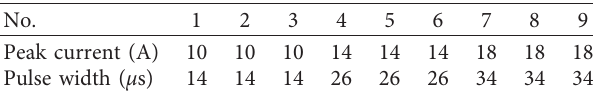
Table 2: Factors and levels for the experiment.